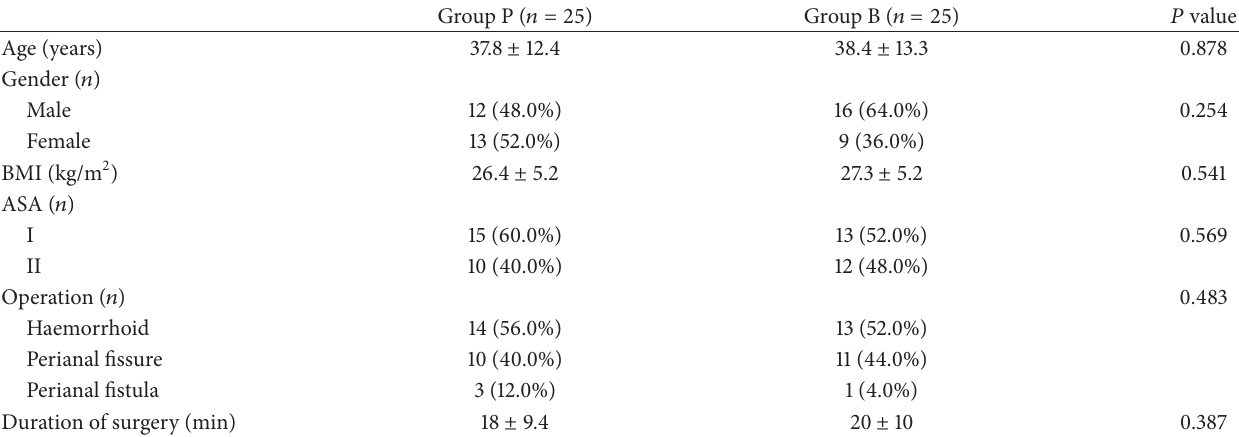
Table 1: Patient characteristics and surgical data.